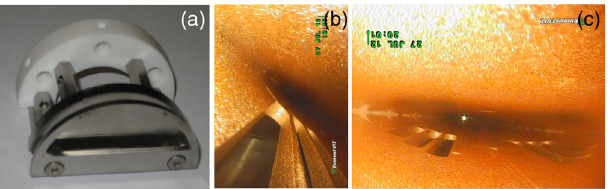
FIG. 9. Half-moon shaped RFA mounted into COLDDIAG without tungsten grid (a), the tungsten grid of the RFA under the pumping holes (b), and the pumping holes in the cold liner section (c).